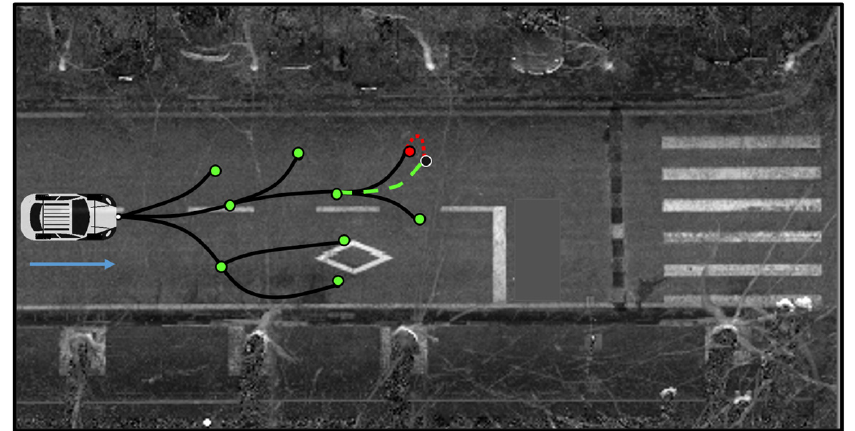
Figure 12. Turning radius constraint.